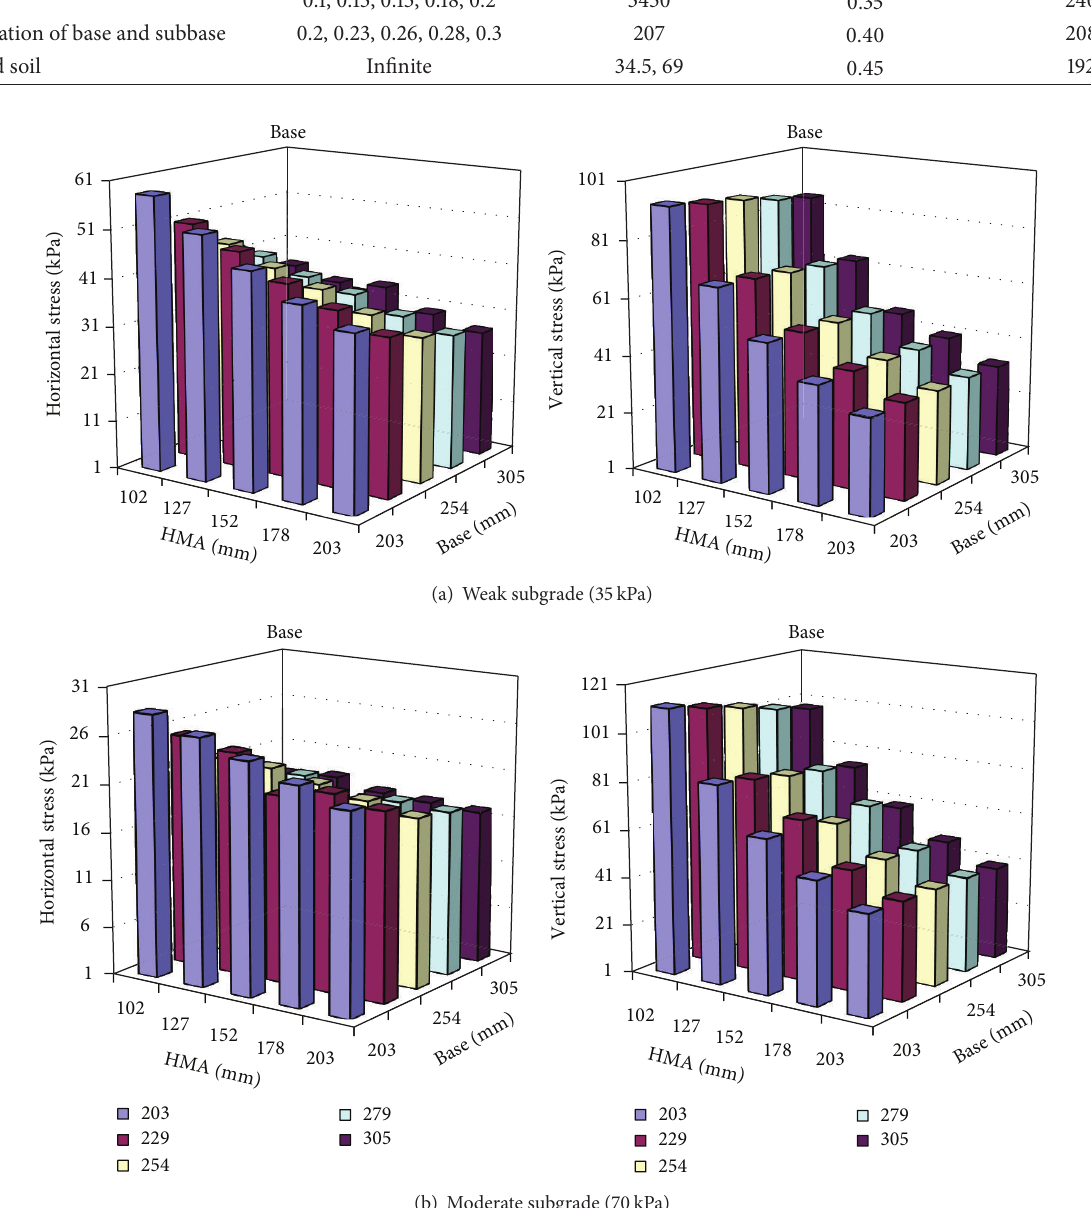
Figure 1: Stress level at the middle of the